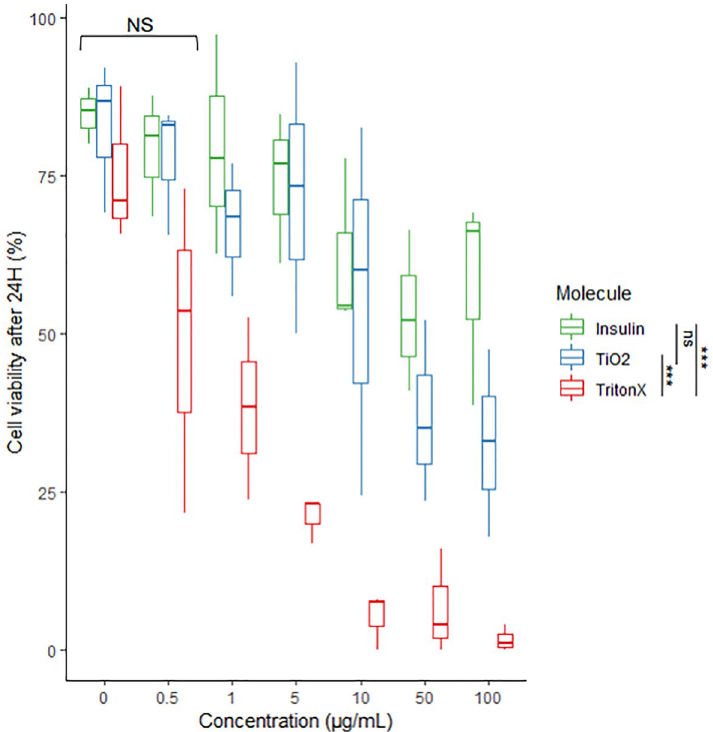
Figure 5. Coral cell viability after 24 h exposure to concentrations of Triton X-100 (positive control, cell lysate), titanium dioxide (TiO 2 ) and insulin between 0.5 and 100 µg/mL. The boxes summarize the data with median (bold line) and outliers (whiskers). The different molecules tested yielded statistically significant results between 1 and 100 µg/mL but not between 0 and 0.5 µg/mL (NS). The control used (Triton X-100) yielded significantly different results compared to